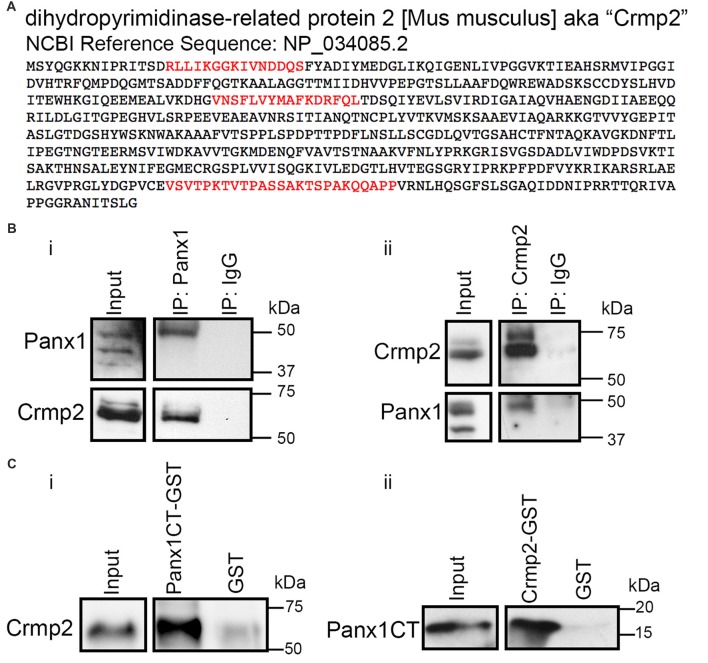
Pannexin 1 (Panx1) and collapsin response mediator protein 2 (Crmp2) interact. (A) Crmp2 peptides (red) identified previously by immunoprecipitation (IP) coupled to LC-MS/MS in Wicki-Stordeur and Swayne (2013). Peptides were identified specifically in IPs from Panx1-EGFP expressing Neuro-2a (N2a) cells, and not EGFP controls. (B) Western blot of endogenous IPs from N2a cell lysates. (i) Crmp2 precipitates specifically with Panx1 compared with IgG control. (ii) Panx1 precipitates specifically with Crmp2 compared with IgG control. (C) Western blots of an in vitro binding assay using purified Crmp2 and Panx1 C-terminus (Panx1CT). (i) The Panx1CT enriches with immobilized Crmp2-GST compared with GST control. (ii) Crmp2 enriches with Panx1CT-GST compared with GST control. These results are representative of three independent replicates. For the complete blots of parts (B,C), see Supplementary Material. This data was previously included in the PhD thesis of LWS (link: https://dspace.library.uvic.ca/handle/1828/6938).